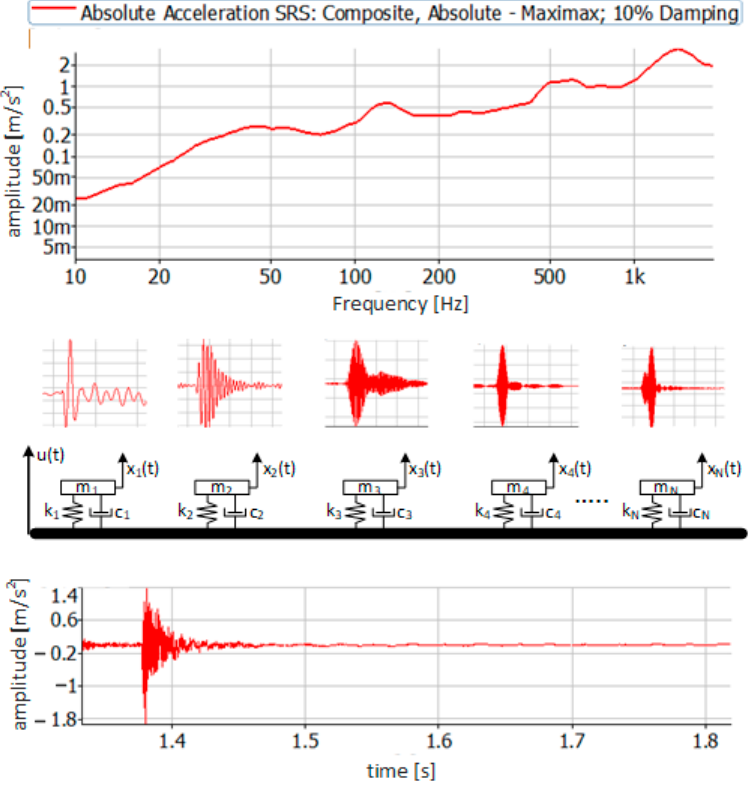
Figure 5. Graphical interpretation of Shock Response Spectrum (SRS) creation.